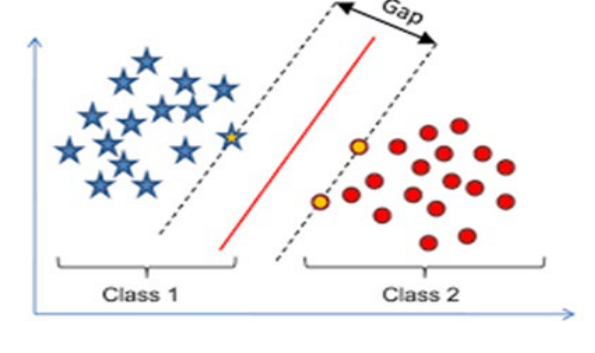
Table 1. CSCP simulation